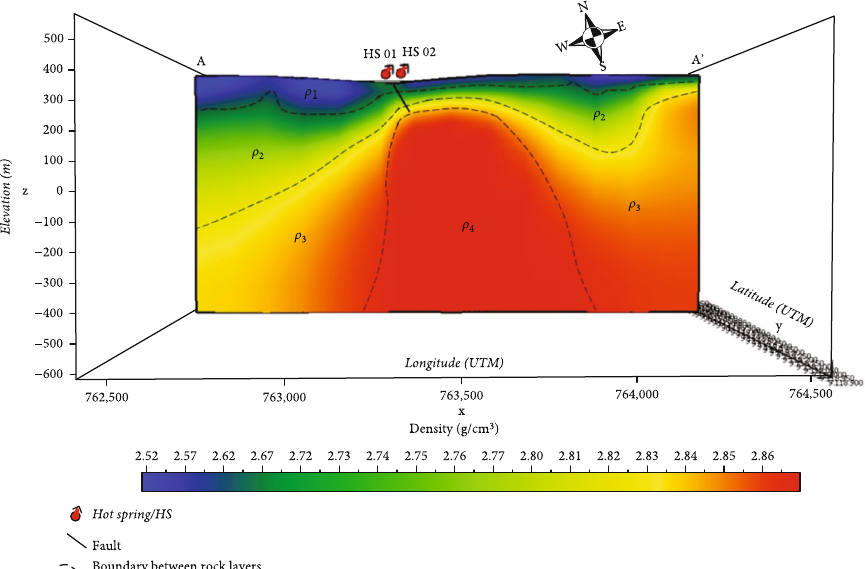
Figure 14: Cross-section of the A-A ” incision on the body of the 3D inversion model.